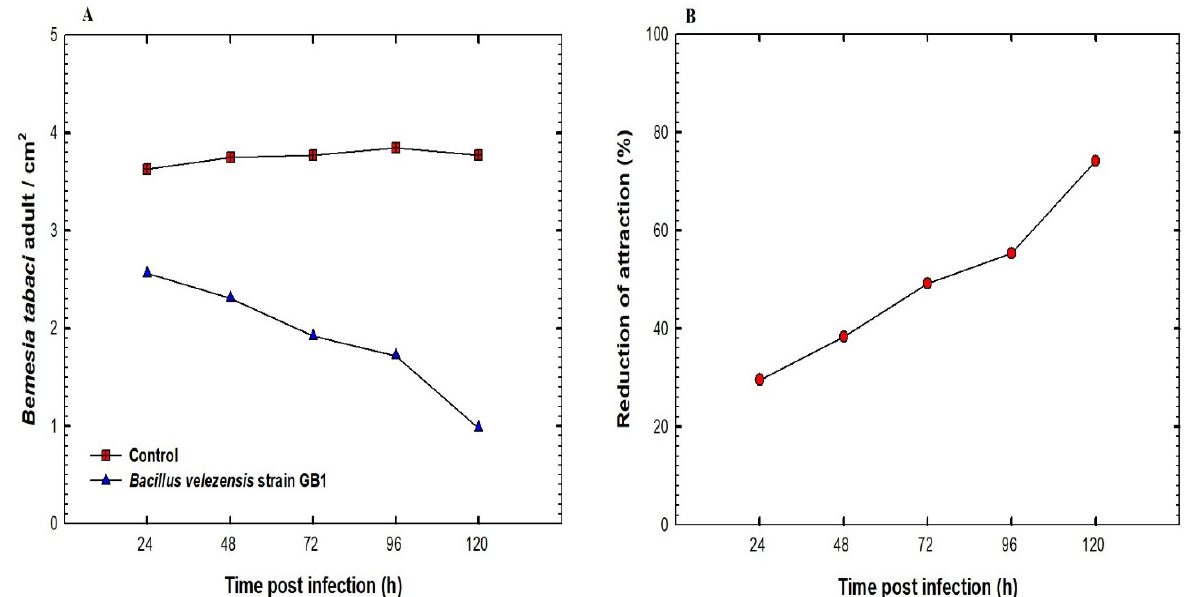
Figure 4. The effect of squash plants’ inoculation with Bacillus velezensis Stain GB1 on ( A ) the population density and ( B ) the attraction reduction percentage of Bemisia tabaci .